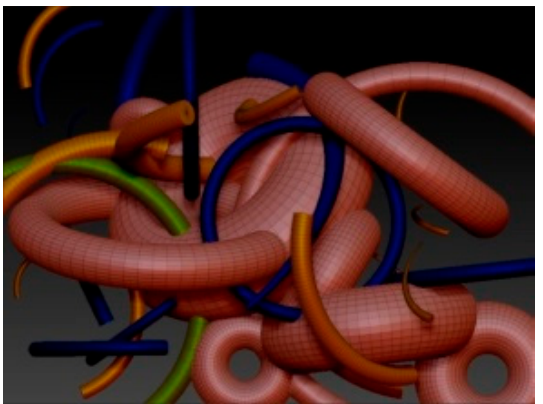
Figure 2. Images obtained through a solid modeller. Author: Matteo Romanato.